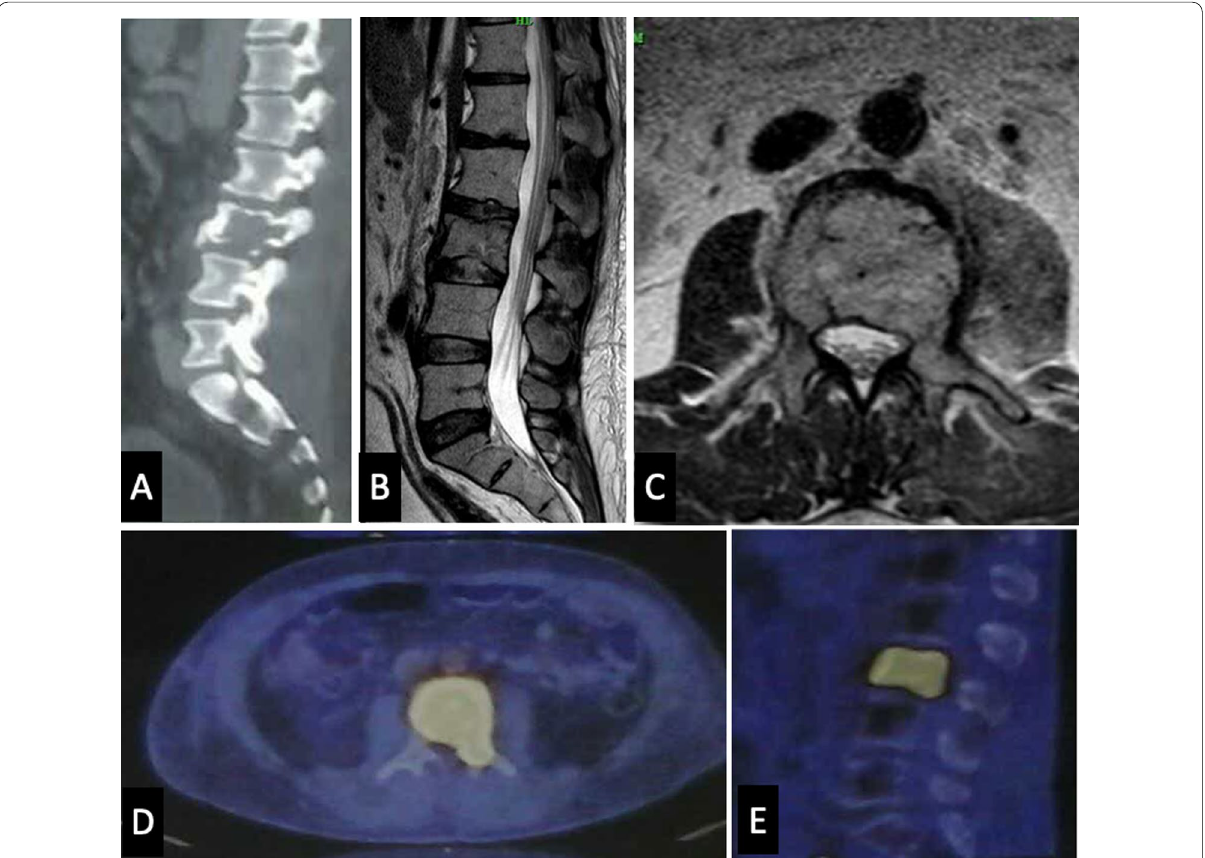
Fig. 1 A , B , C CT Scan sagittal, MRI sagittal T2 sequence, MRI T2 axial sequence showing L3 vertebral affection predominant left side with beyond pars involvement. D , E PET scan showing high FDG